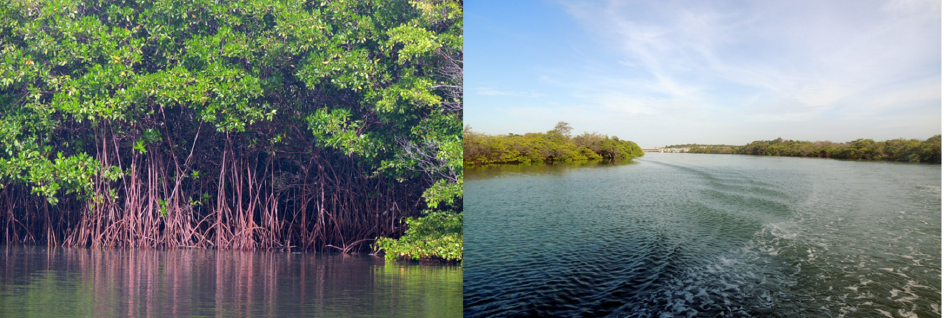
Figure 2. Piranji Estuary (equatorial Southwestern Atlantic, Brazil) with mangrove forests ( left side) and the well-mixed shallow estuarine environment ( right side).